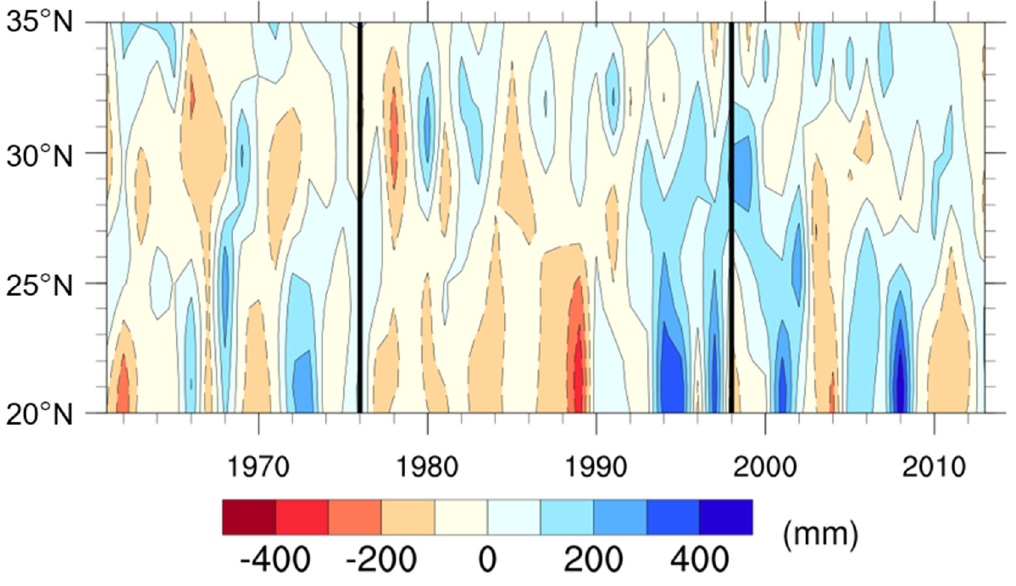
Figure 1. Variation of summer (JJA) precipitation anomalies averaged over 110° E–122° E. The climatological mean is calculated from 1971 to 2000; the unit is mm.